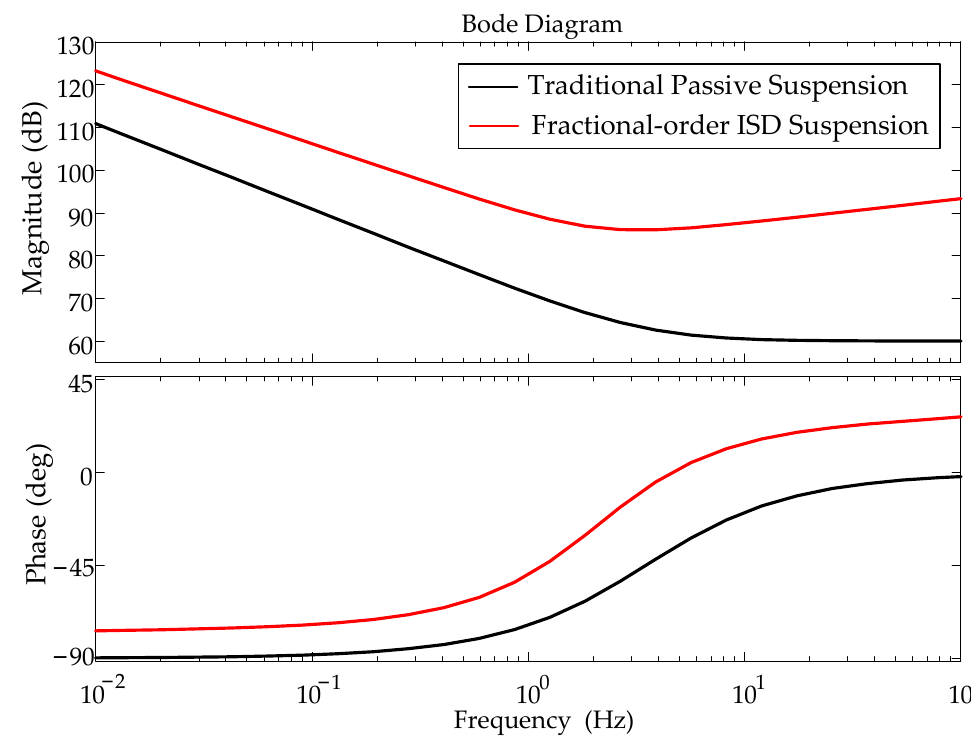
Figure 7. Bode diagram comparison of two suspension systems.